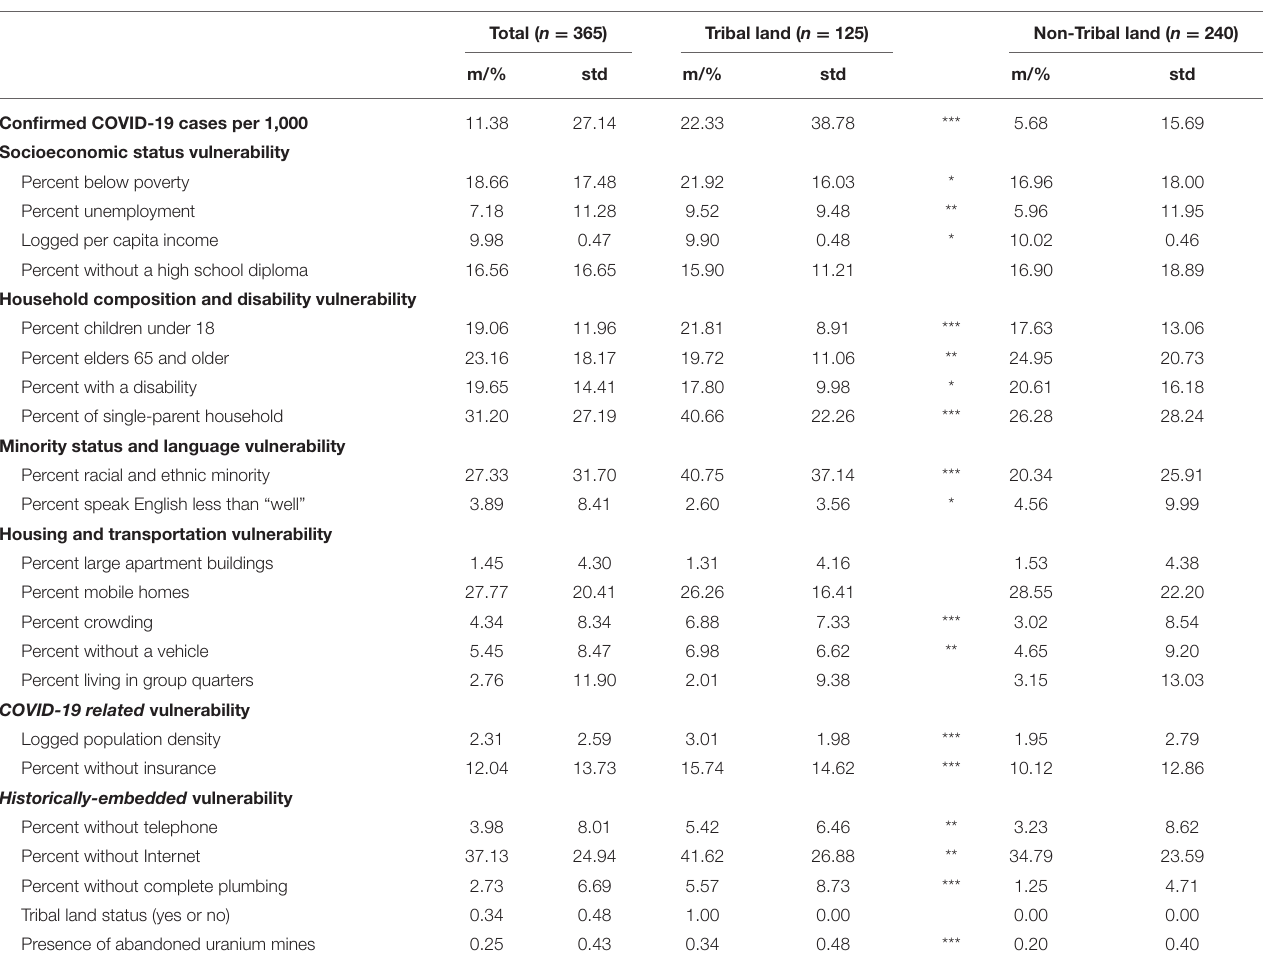
TABLE 1 | Descriptive statistics by Tribal land status.